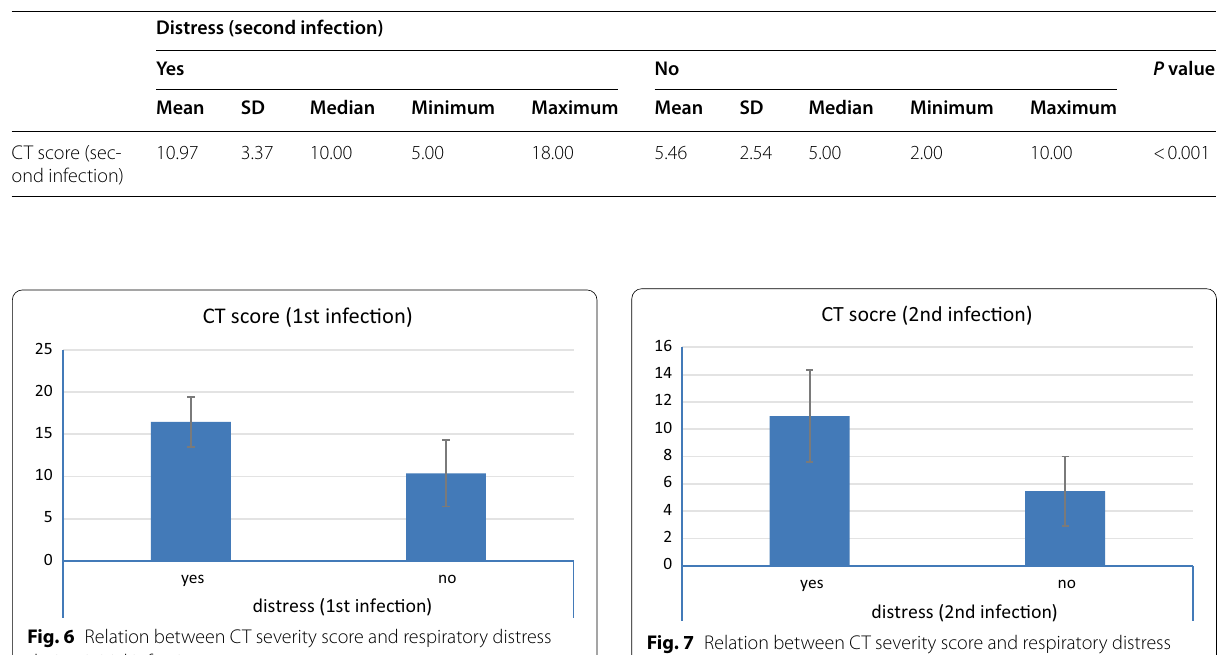
Table 8 Relation between distress and CT severity score (during second infection)